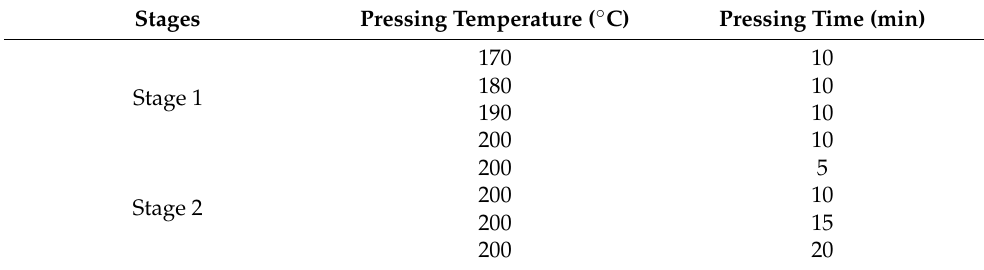
Table 1. Conditions of manufacture for